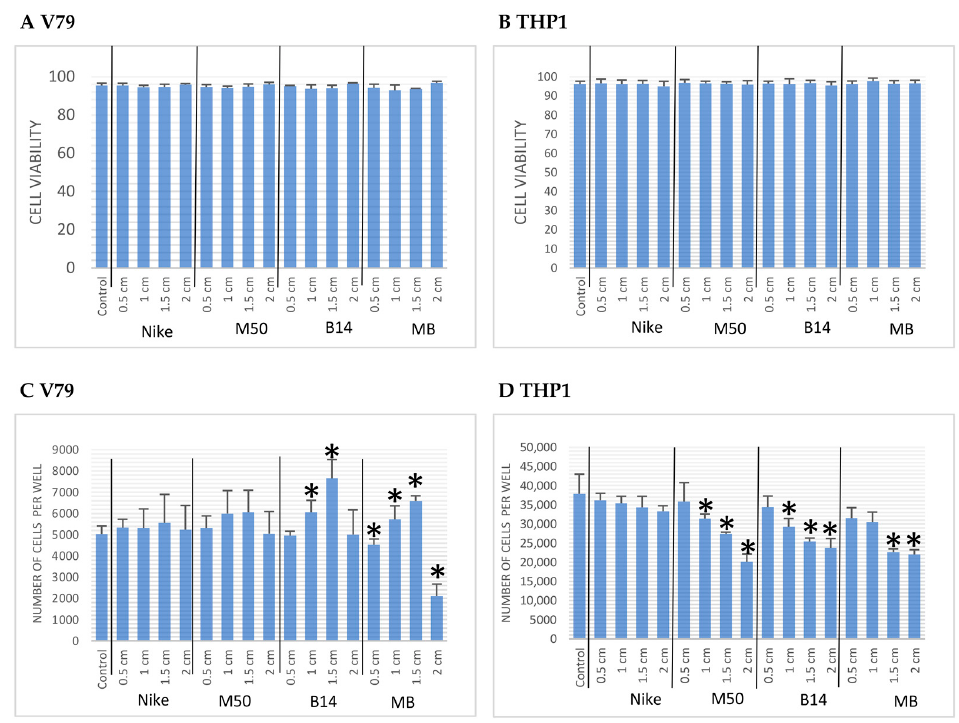
Figure 3. The Balb/3T3 cells viability after 48 h of incubation with the tested linen fabric on four different surfaces (0.5, 1.0, 1.5 and 2.0 cm). The statistical significance of the differences between the results for the tested linen fabric compared to the control was calculated using Tukey’s post hoc test ( * p < 0.05).